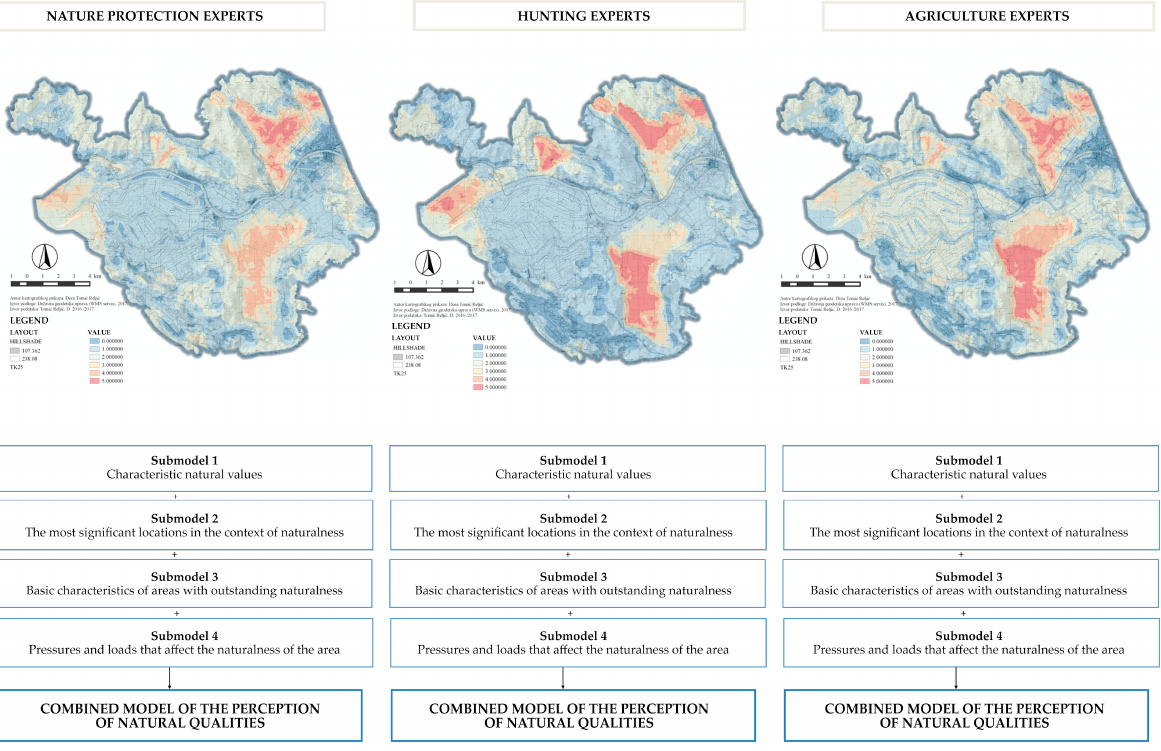
Figure 3. The process of creating models of the perception of natural qualities .